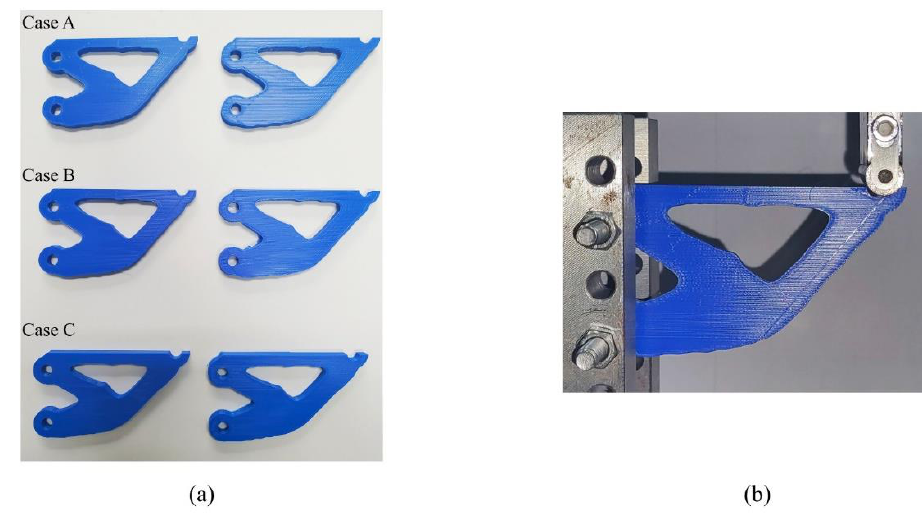
Figure 17. It is found that the cantilever optimized by our method is stiffer than the others, which confirmed the numerical predictions.